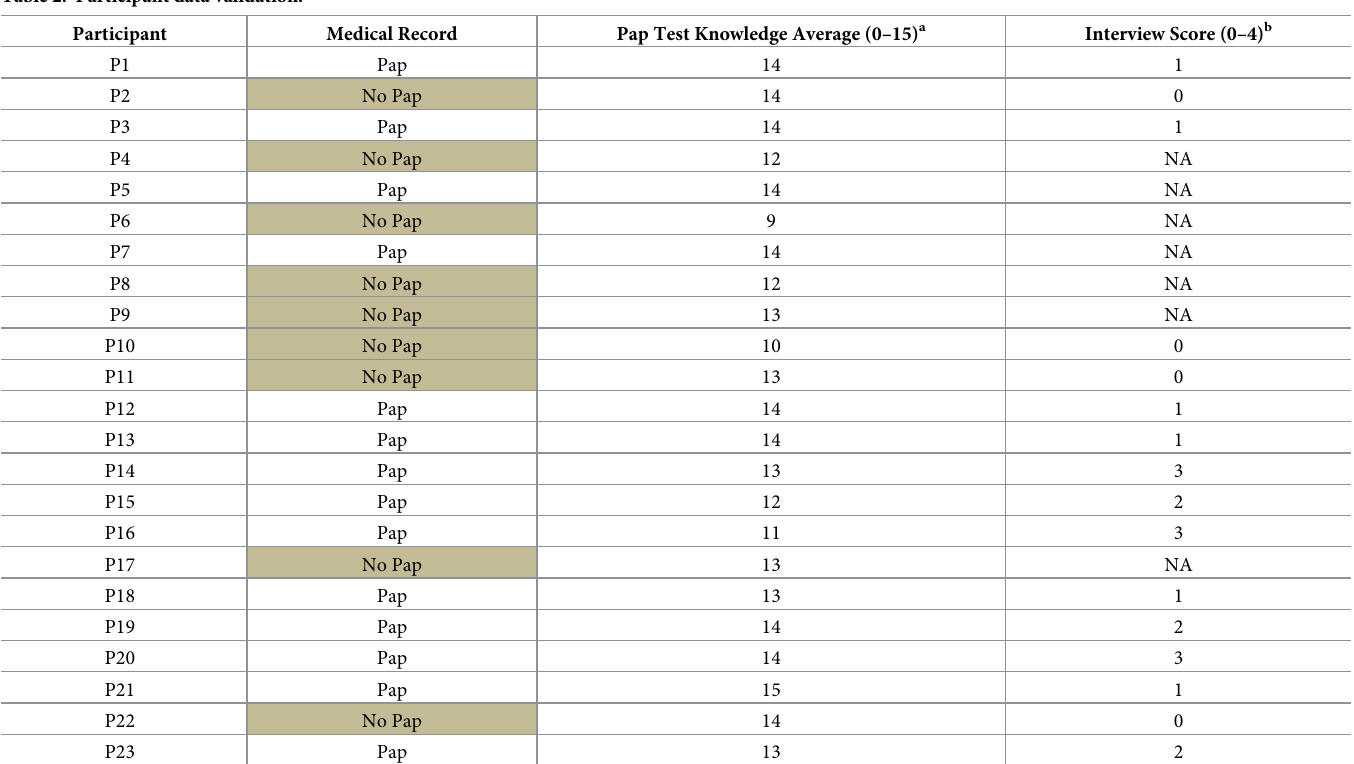
Table 2. Participant data